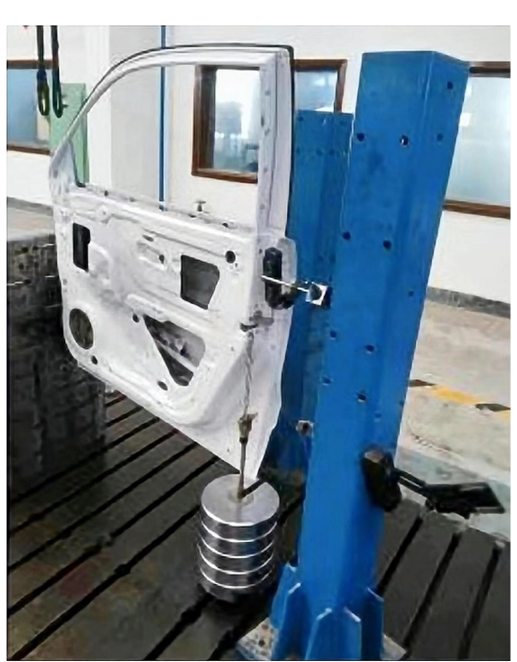
Table 2. Comparison of FE simulations and experimental test.